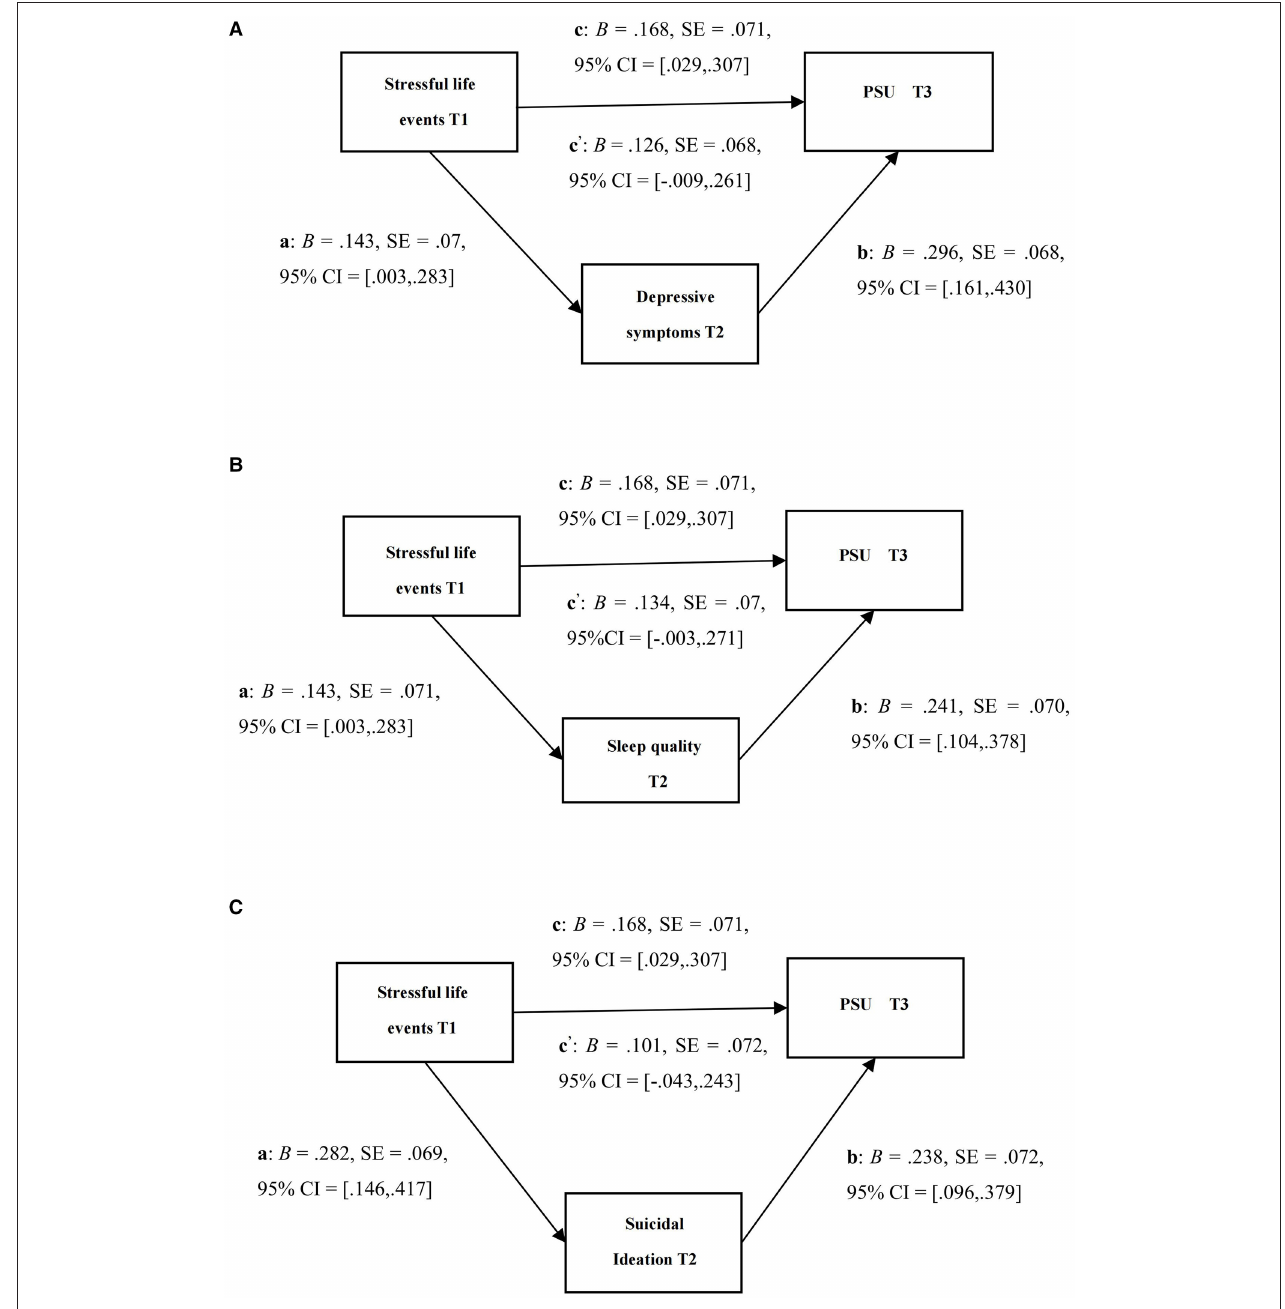
FIGURE 3 | (A) The mediation model including stressful life events at T1, depressive system at T2, and PSU at T3; (B) The mediation model including stressful life events at T1, sleep quality at T2, and PSU at T3; (C) The mediation model including stressful life events at T1, suicidal ideation at T2, and PSU at T3. Note c: total effect, c ′ : direct effect; b: standardized regression coefficient, SE: standard error, CI: confidence interval.